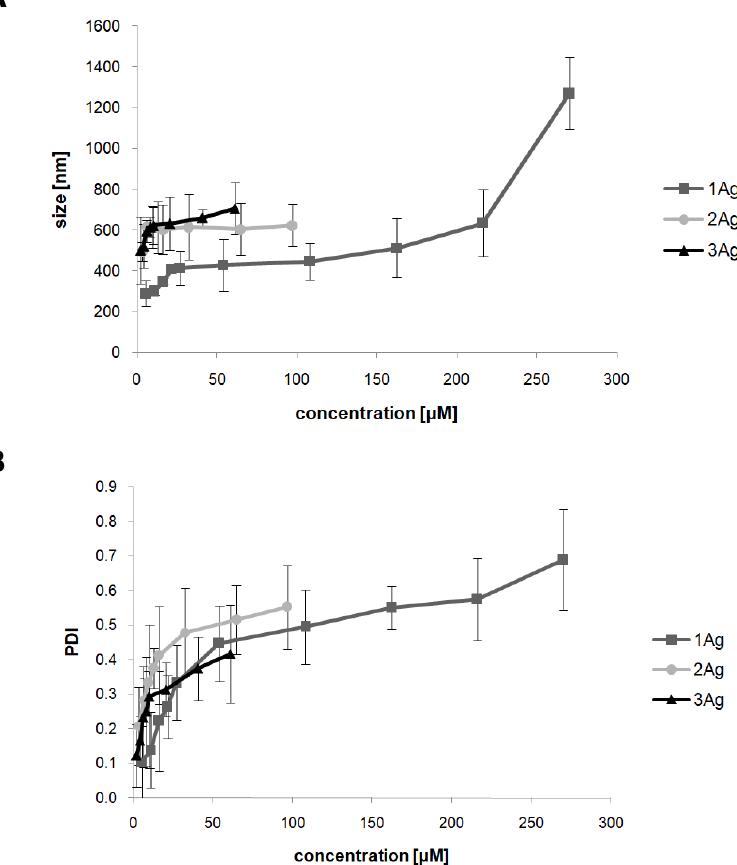
Figure 5. Changes in the hydrodynamic diameter ( A ) and polydispersity index ( B ) of AgNP:siRNA (siBcl-xl) complexes as a function of increasing concentrations of AgNPs. The abscissa values refer to the dendron concentration. Data presented as mean ± SD, n = 3 (8 measurements each).